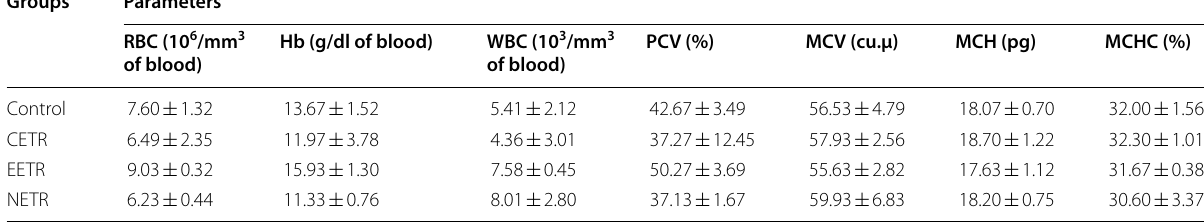
RBC red blood cell count, Hb hemoglobin concentration, WBC white blood cell count, PCV packed cell volume, MCV mean corpuscular volume, MCH mean corpuscular hemoglobin, MCHC mean corpuscular hemoglobin concentration, CETR chloroform extract treated rats, EETR ethanol extract treated rats, NETR n-hexane extract treated rats